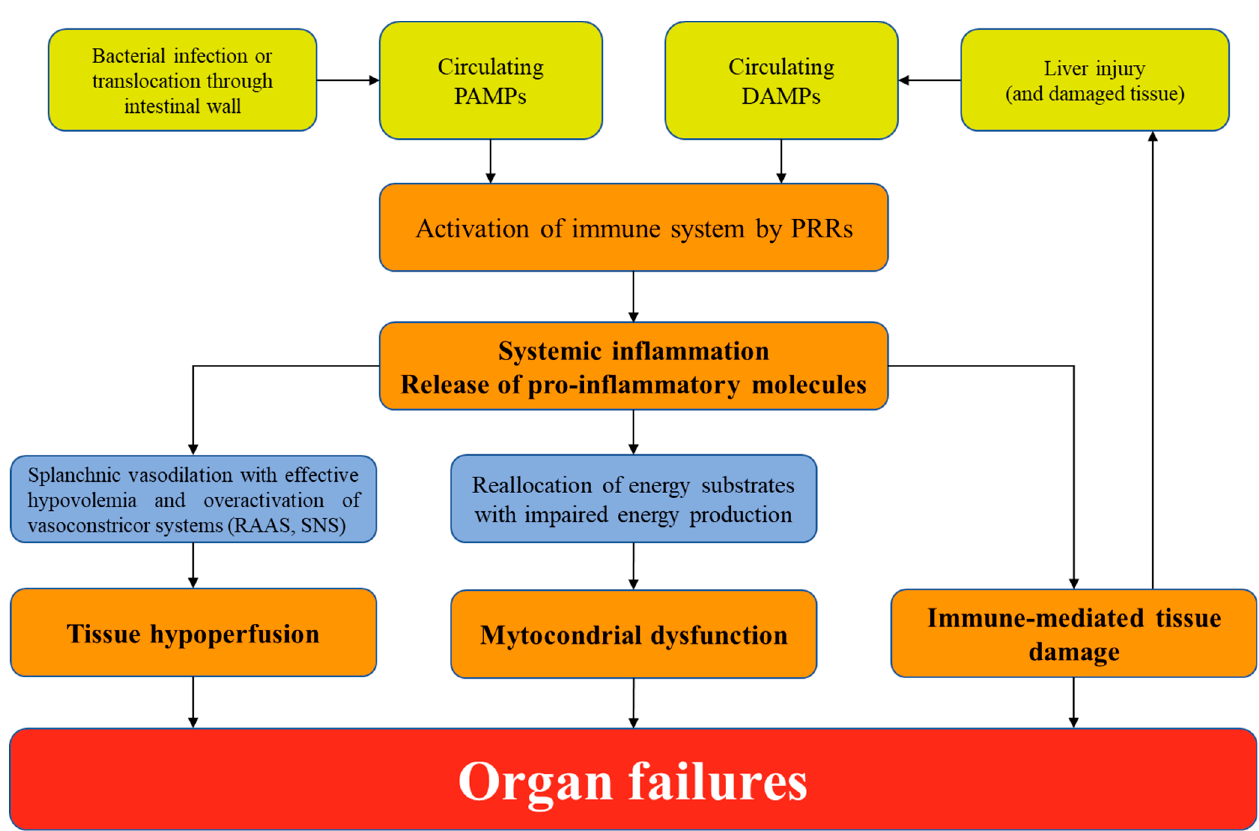
Figure 1. Pathophysiology of ACLF. PAMPs, pathogen-associated molecular patterns; DAMPs, damage-associated molecular patterns; PRR, pattern-recognition receptors; RAAS, renin-angiotensin-aldosterone system; SNS, sympathetic nervous system.